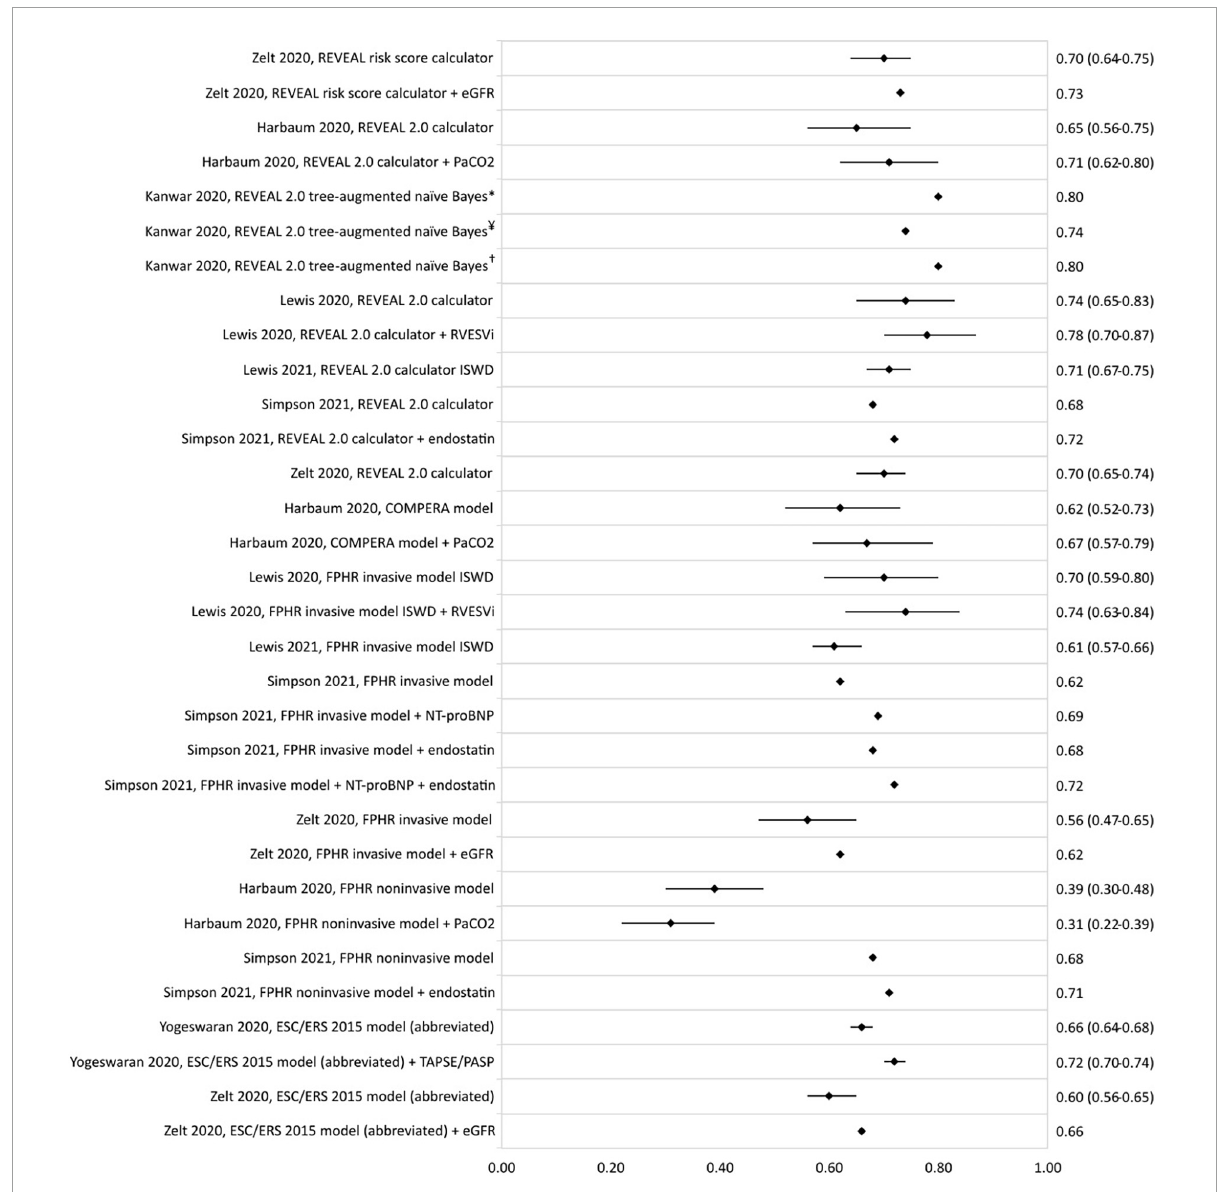
FIGURE4 C-statistic (95% CI) of the enhancement of REVEAL and ESC/ERS 2015 guideline-based risk stratification models, as well as the c-statistic of the original model in the same population. eGFR, estimated glomerular filtration rate; PaCO2, arterial carbon dioxide partial pressure; RVESVi, right ventricular end-systolic volume index; ISWD, incremental shuttle walk distance; NT-proBNP, N-terminal-pro brain natriuretic peptide; TAPSE/PASP, tricuspid annular plane systolic excursion/systolic pulmonary artery pressure ratio. ∗ REVEAL cohort, (cid:85) COMPERA cohort, and † PHSANZ